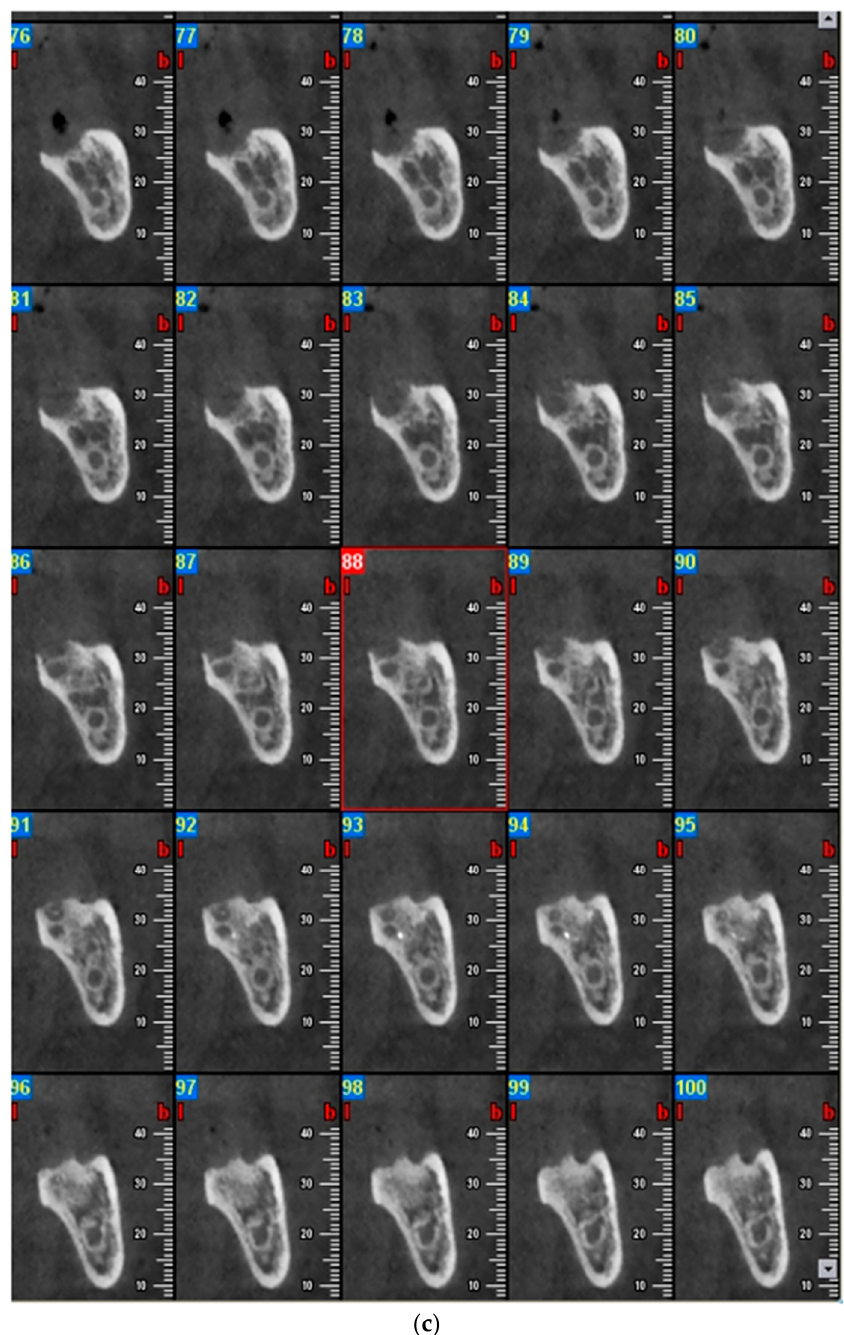
Figure 2. Case 1: Cone ‐ beam computer tomography images: ( a ) 3D reconstruction; ( b ) Panorex; ( c ) CT scan images of the bone exposition.